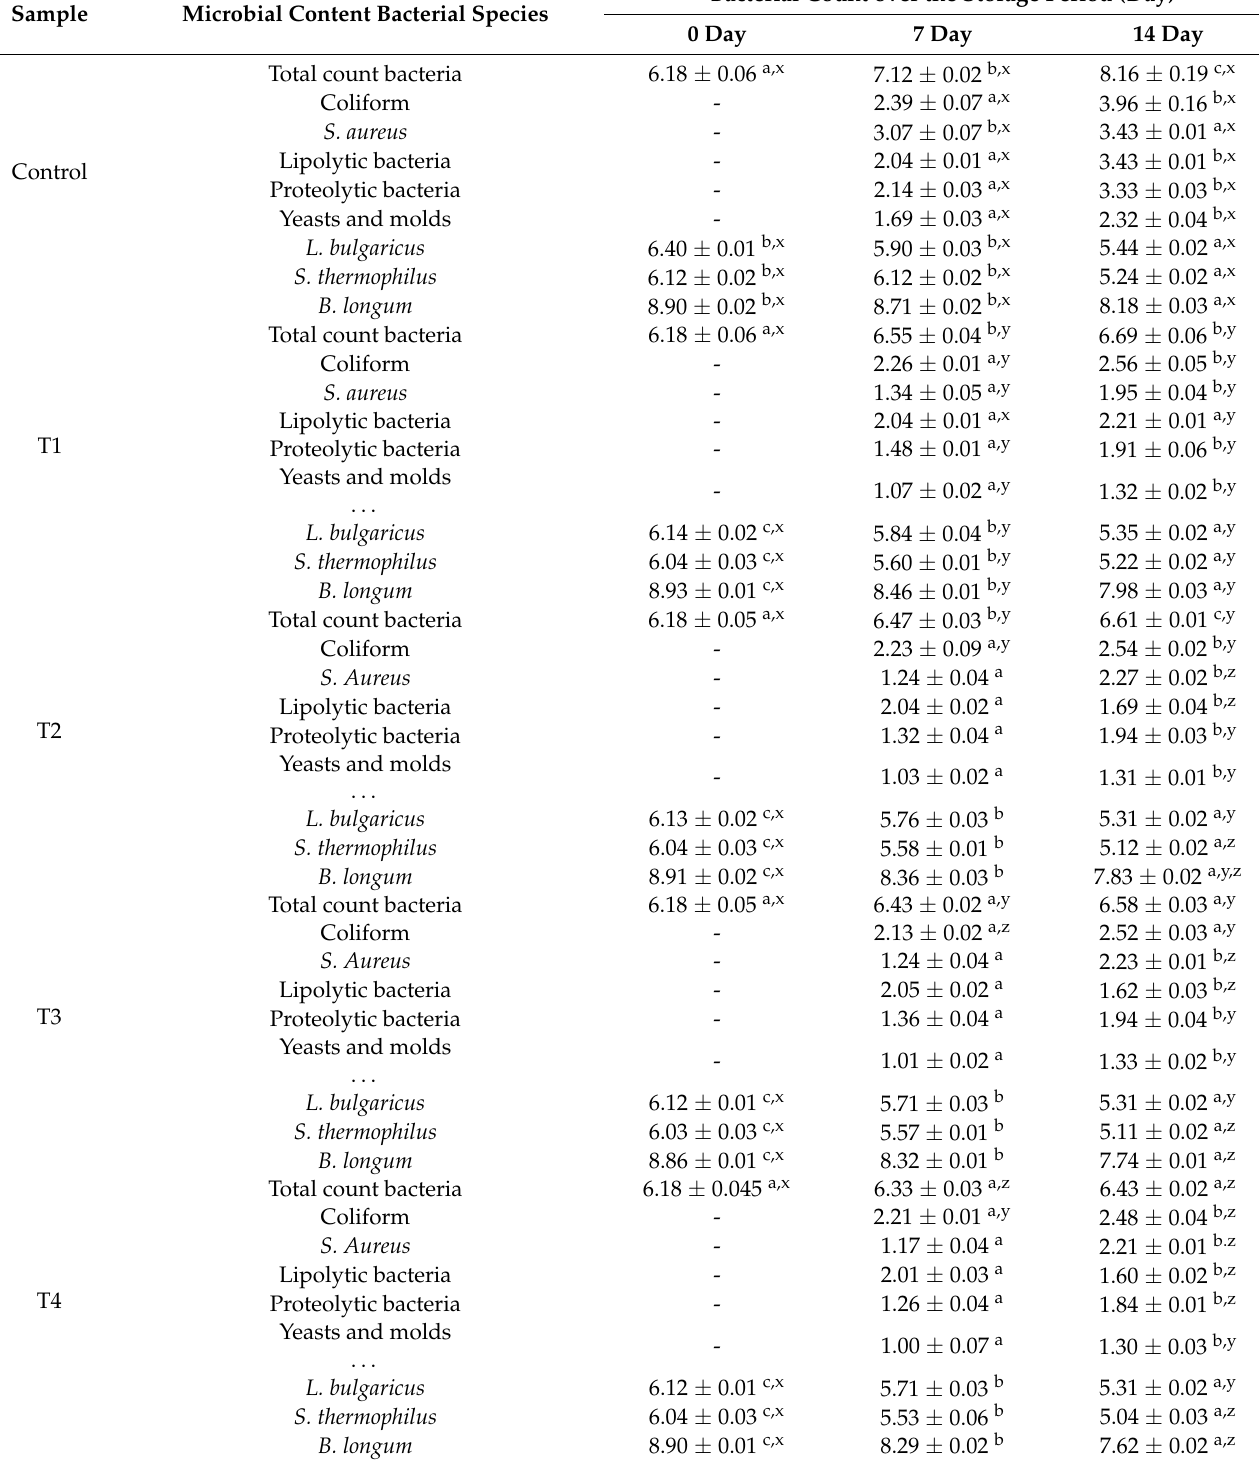
T1: yoghurt fortified with 1.5% of Rosmarinus officinalis L. aqueous extract. T2: yoghurt fortified with 2.0% of Rosmarinus officinalis L. aqueous extract. T3: yoghurt fortified with 2.5% of Rosmarinus officinalis L. aqueous extract. T4: yoghurt fortified with 3.0%